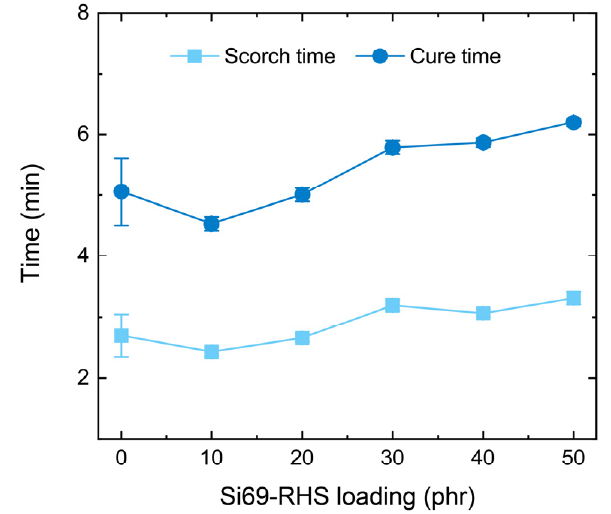
Figure 6. Scorch and cure times of the NR compounds filled with various Si69-RHS loadings.